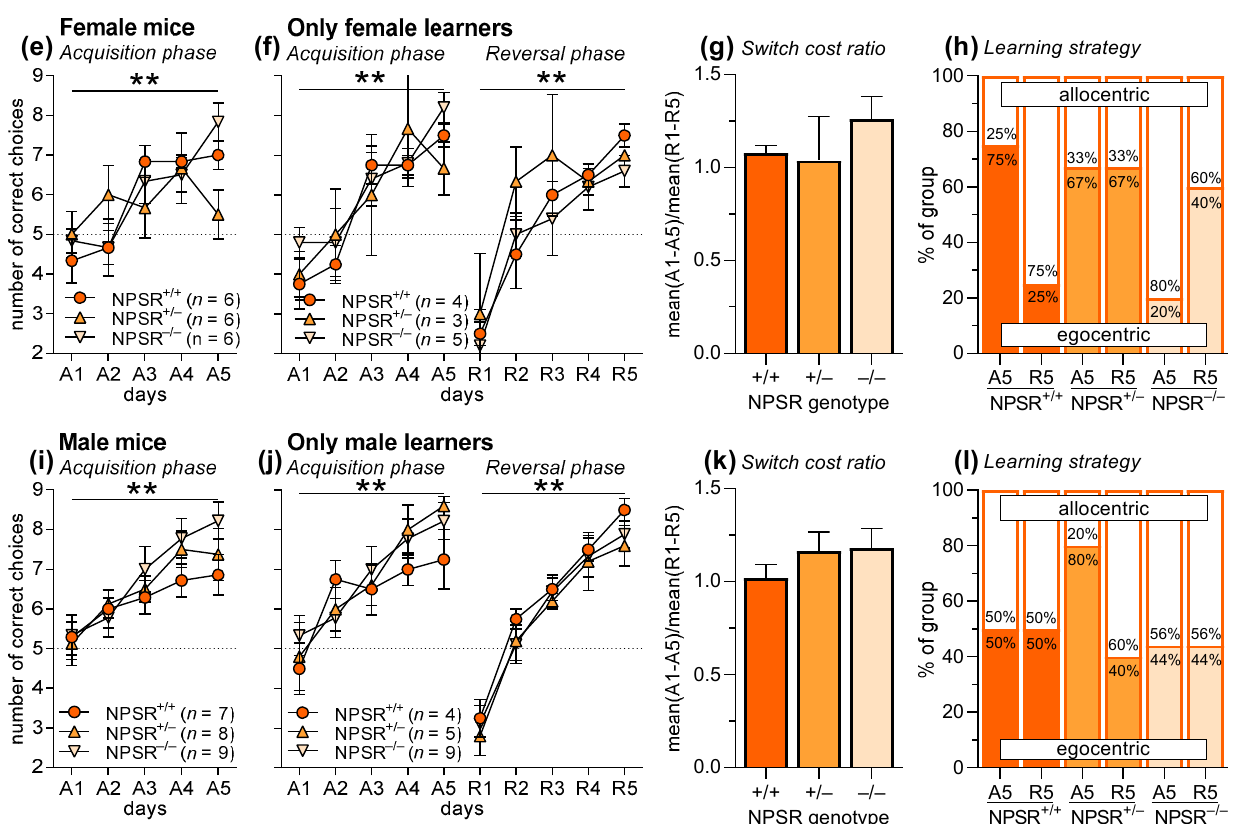
Figure 1. T-maze discrimination and reversal learning in wild-type, heterozygous and homozygous NPSR-deficient mice. Panels ( a – d ) depict the data for both sexes pooled, panels ( e – h ) and ( i – l ) show the data separated for female and male mice, respectively. ( a ) Mice learned well to discriminate the two arms of the T-maze; however, NPSR deficiency improved this learning. ( b ) For the analyses of reversal learning and learning strategy, mice that did not acquire discrimination learning during A1–A5 were excluded. It is notable that there were significantly less non-learners in NPSR − / − mice. Mice that acquired discrimination learning (A1–A5) also learned the reversal task well (R1–R5), and NPSR deficiency had no effects. ( c ) This is confirmed by the analysis of the switch cost ratio, i.e., the ratio of the mean performance during acquisition and the mean performance during reversal learning. ( d ) In addition, learning strategy was not affected, either by phase of the experiment (acquisition, reversal) or by NPSR deficiency. Panels ( e – h ) and ( i – l ) show the same data separated by sex. Apart from the findings that female NPSR +/ − mice did not acquire the task ( e ), the result patterns are similar to those of the pooled data. ** p < 0.01, main effect of days (ANOVA), # p < 0.05, post-hoc comparison with NPSR +/+ .